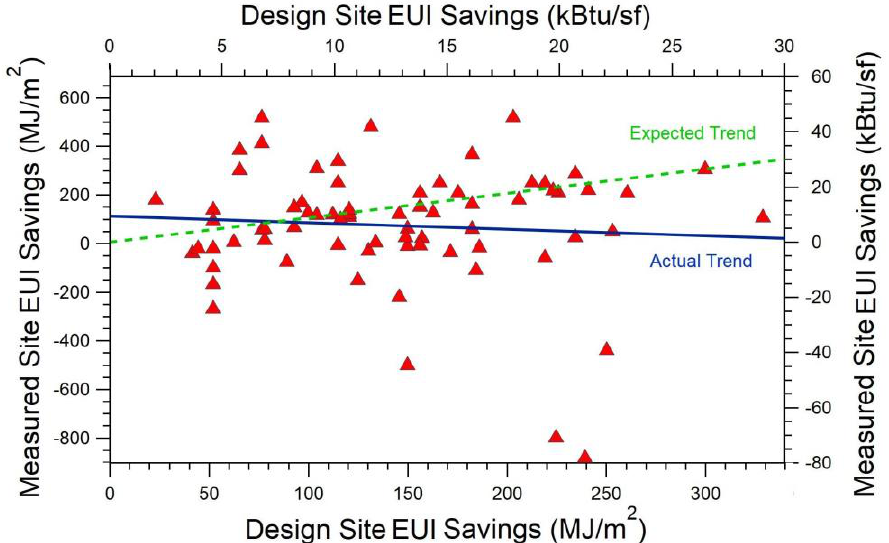
Figure 4. A graph of measured site EUI savings vs. those projected from EAc1 points awarded for LEED certification for 74 LEED offices certified in the NC (New Construction) or CS (Core and Shell) systems. The dashed green line represents the expected result when the measured and projected savings are the same.